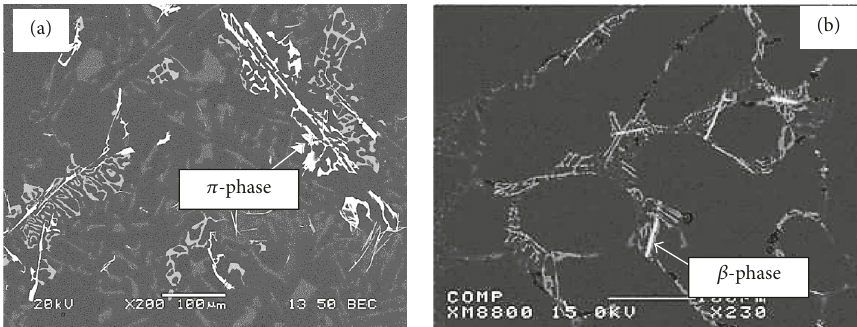
Figure 4: Backscattered electron images of A356 alloy in the as-cast condition: (a) nonmodified and (b) modified with 100 ppm Sr, showing 𝜋 -phase and 𝛽 -phase